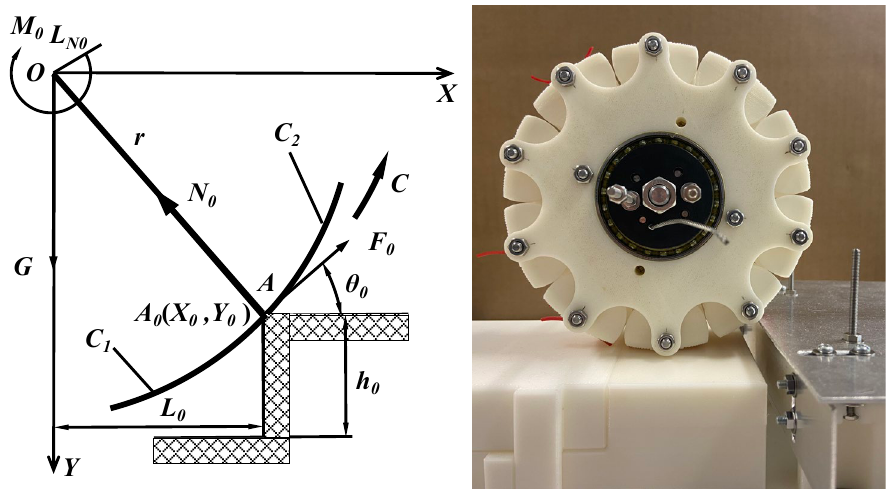
Figure 2. Mechanical analysis of round wheel ( Left : force diagram; Right : actual contact).